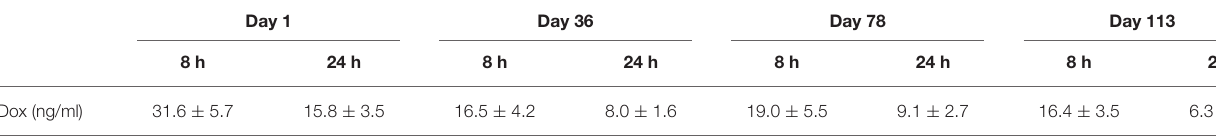
All values are means ± SD (N = 12; except day 113 was N = 6).